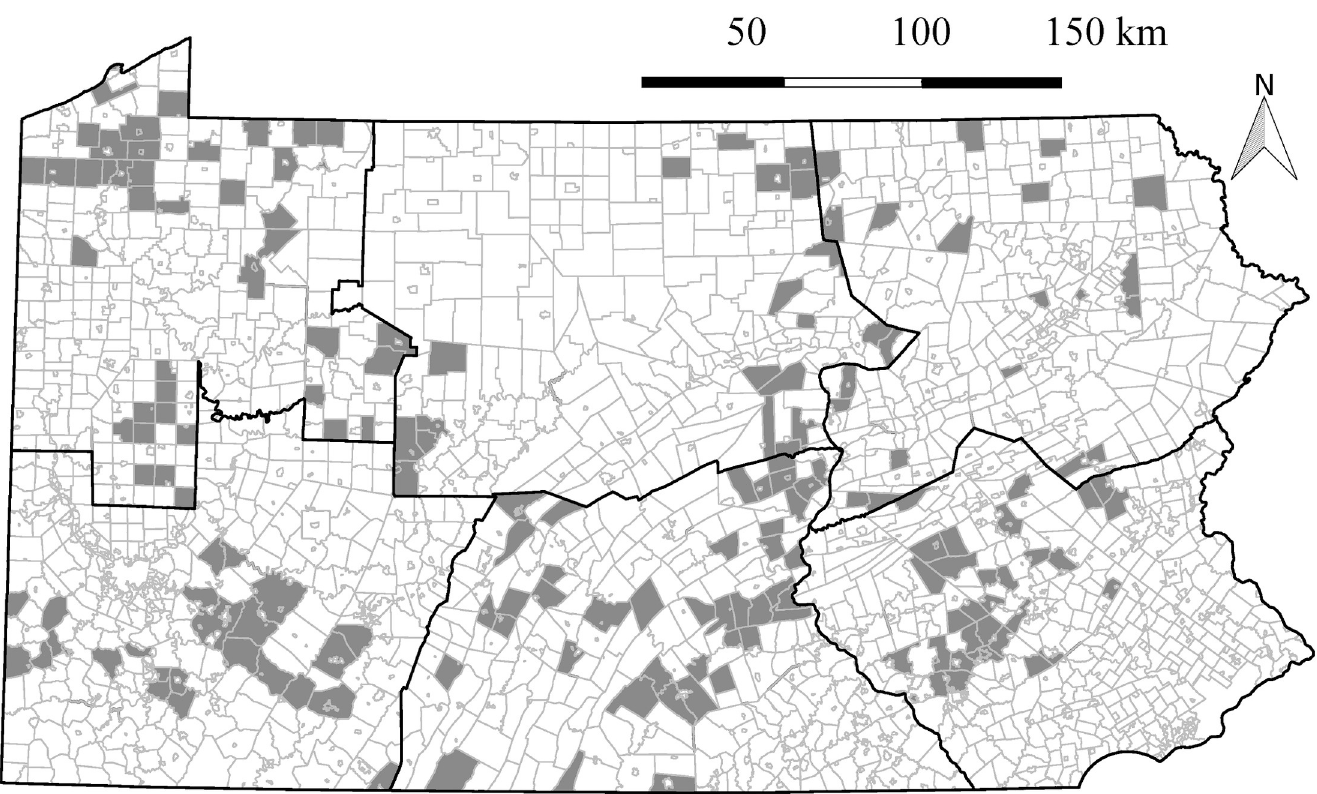
Fig 1. Townships in Pennsylvania, USA where muskrat ( Ondatra zibethicus ) carcasses were collected from trappers in 2018–2019 as indicated by shaded areas. Six regions designated by the Pennsylvania Game Commission are indicated by bold outlines (Game Regions layer provided by Pennsylvania Spatial Data Access [13]).